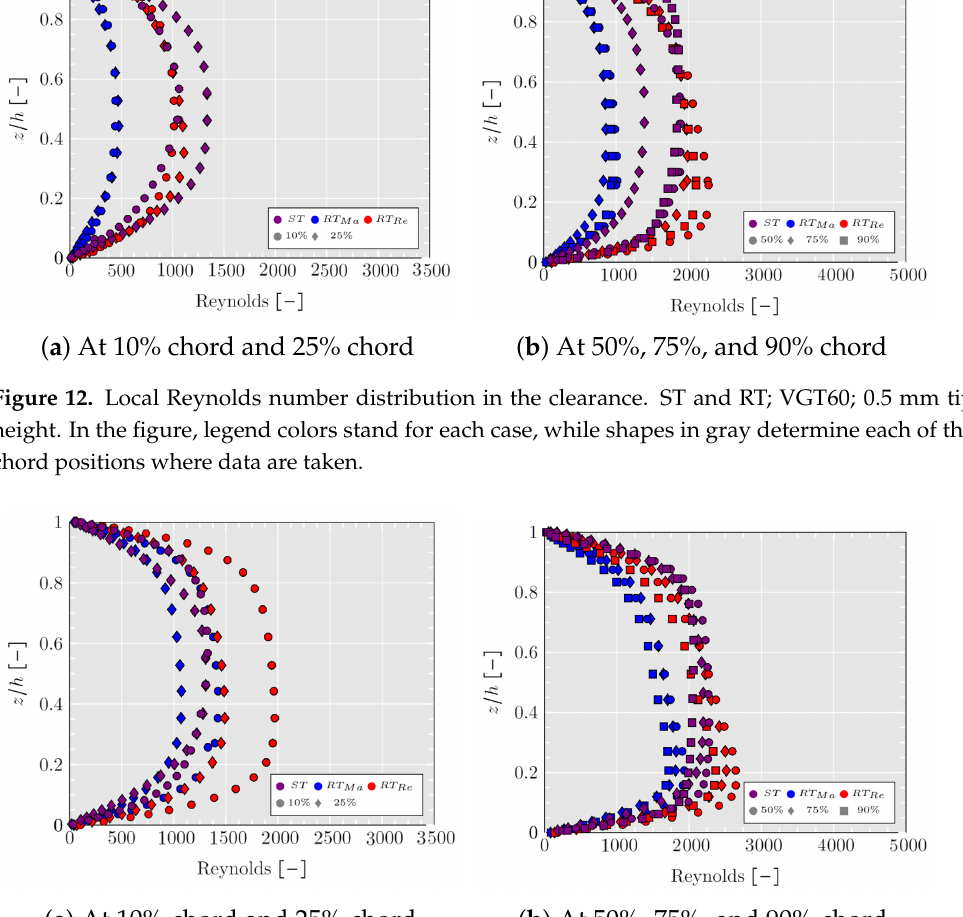
Figure 12. Local Reynolds number distribution in the clearance. ST and RT; VGT60; 0.5 mm tip height. In the figure, legend colors stand for each case, while shapes in gray determine each of the chord positions where data are taken.